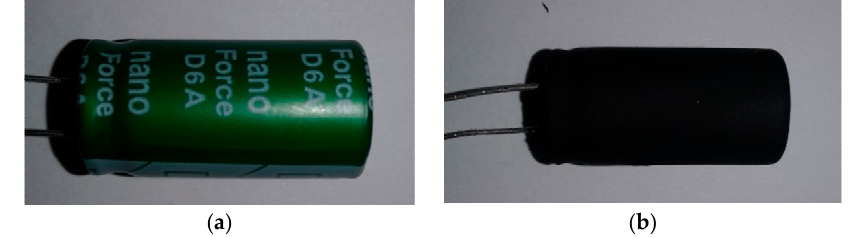
Figure 1. Photo of tested capacitors, ( a ) without graphite coating; ( b ) with graphite coating. Table 2. Basic parameters of tested capacitors 4 [13]. ESR : equivalent series resistance.